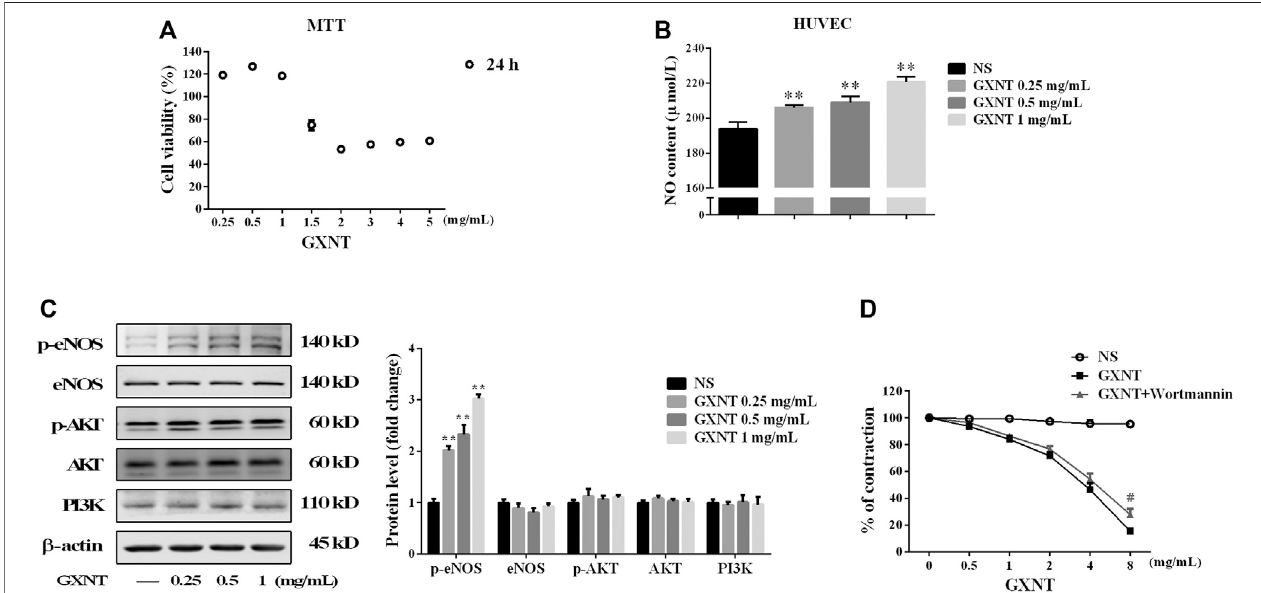
FIGURE 4 | Effects of GXNT on NO synthesis and the related endothelial nitric oxide synthase (eNOS)/PI3K/AKT signaling pathway. (A) Cell viability of human umbilical vein endothelial cells (HUVECs) treated with GXNT at a series of fi nal concentrations (0.25, 0.5, 1, 1.5, 2, 3, 4, and 5 mg/ml) for 24 h. (B) NO content in the cell supernatant.HUVECsweretreatedwith0.25,0.5,and1 mg/mlGXNTfor24 h.Thenthecellsupernatantswerecollectedandcentrifugedat2,000 rpmfor5 minbefore thelevelsofNOweredeterminedbyELISAwithakit. (C) In fl uenceofGXNTontheeNOS/PI3K/AKT-mediatedNO-relatedsignalingpathwayinHUVECs.Cellswere incubated with 0.25, 0.5, and 1 mg/ml GXNT for 24 h, and then the proteins were extracted and determined by Western blotting. Proteins were quanti fi ed according to the gray value of the bands, and the fold changes represent the ratio of other groups to the NS group. (D) Effect of a PI3K inhibitor on the vasodilatory effect of GXNT. Endothelium-intactrings( n (cid:2) 6)werepreincubatedwithwortmannin(10 − 7 M)for30 minbeforeprecontractedwith10 − 6 M PE.AftertreatmentwithGXNT,thechangein tensionwasquanti fi edastheratiooftensionafterGXNTandinhibitoradministrationtothecontractiontensionwithPE( **p < 0.01comparedwiththeNSgroup, # p < 0.05 compared with the GXNT group). Results are presented as the mean ± SD of data obtained in three independent experiments.